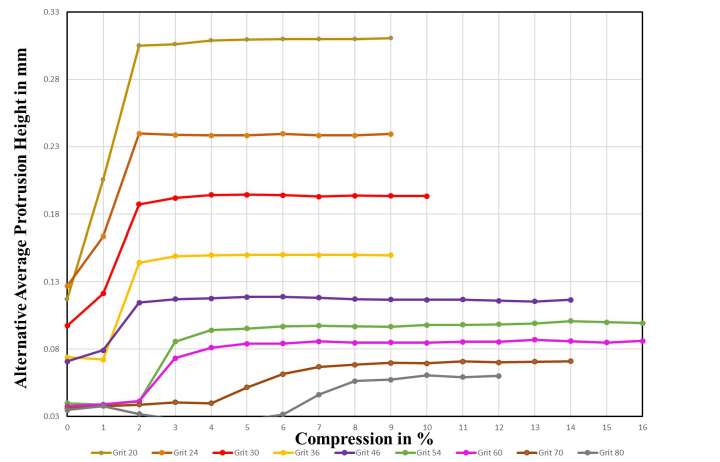
Figure 22. Alternative average protrusion height dependent on different percentages of compression.